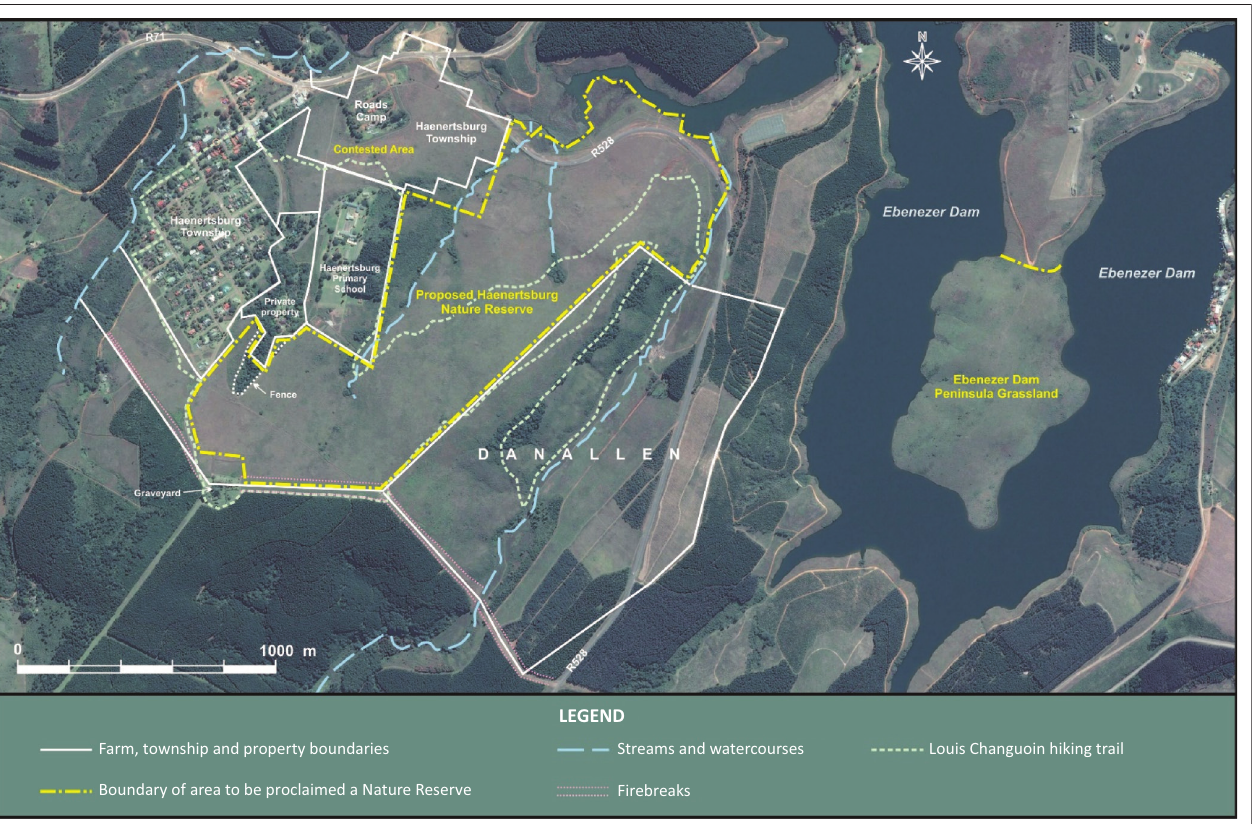
FIGURE 2: Google Earth Pro image (2015) of the two largest remaining Woodbush Grassland fragments under public